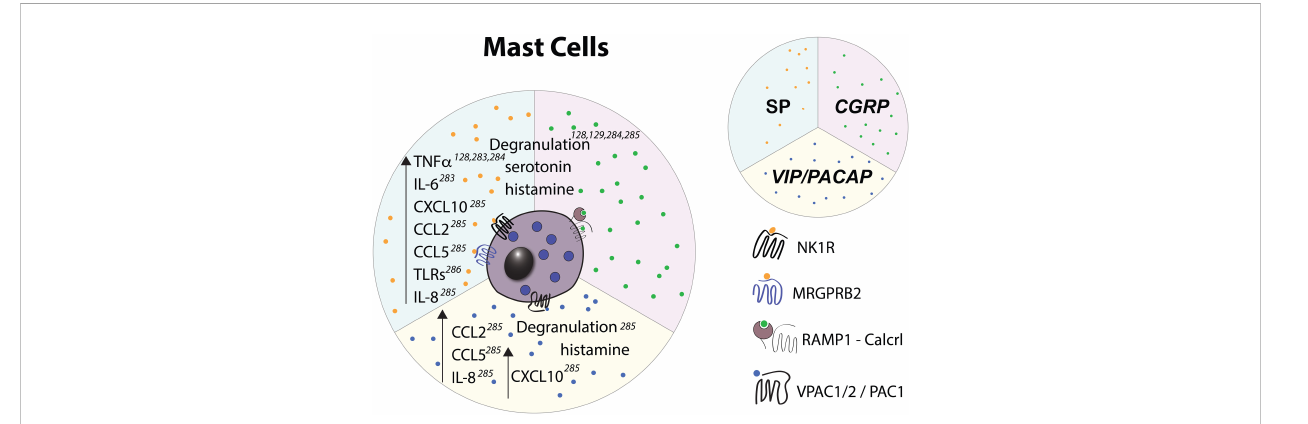
FIGURE 7 Effects of select nociceptive neuropeptides on mast cells observed in vitro . Upward pointing arrows signify upregulation/activation, downward facing arrows signify